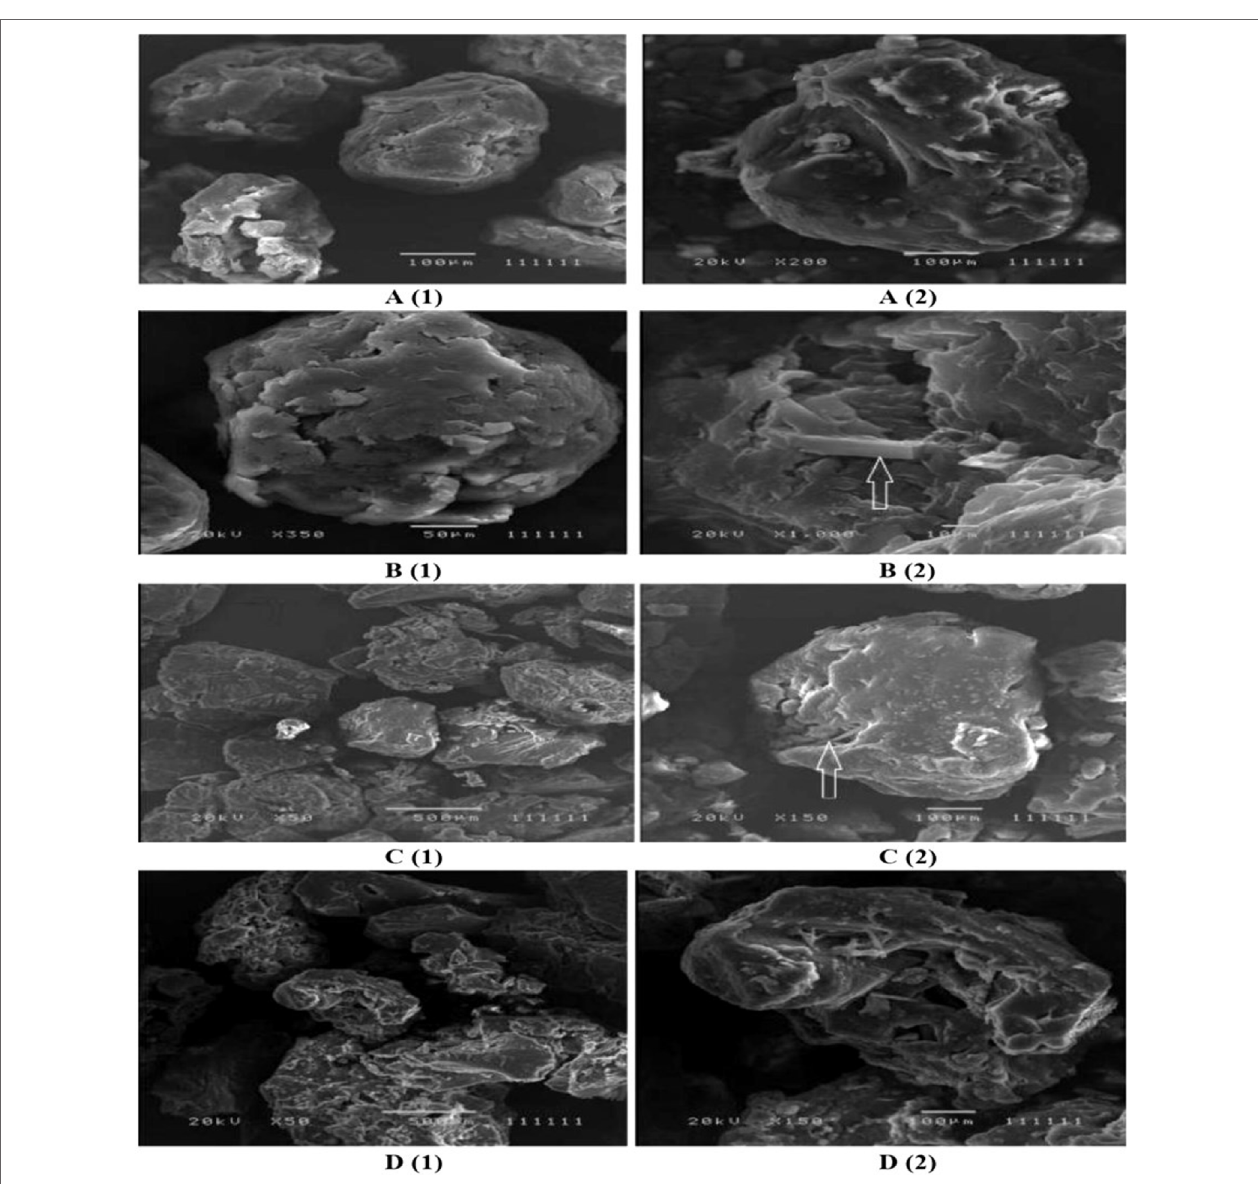
FIGURE 1 | Electron scanning microscope photograph (ESM) of Span 60 microparticles containing drug: (A) (1&2) 25% TDC & normal method. (C) (1&2) 25% TDC & rapid congealing matrix. (B) (1&2) 75% TDC & normal method. (D) (1&2) 75% TDC & rapid congealing matrix.